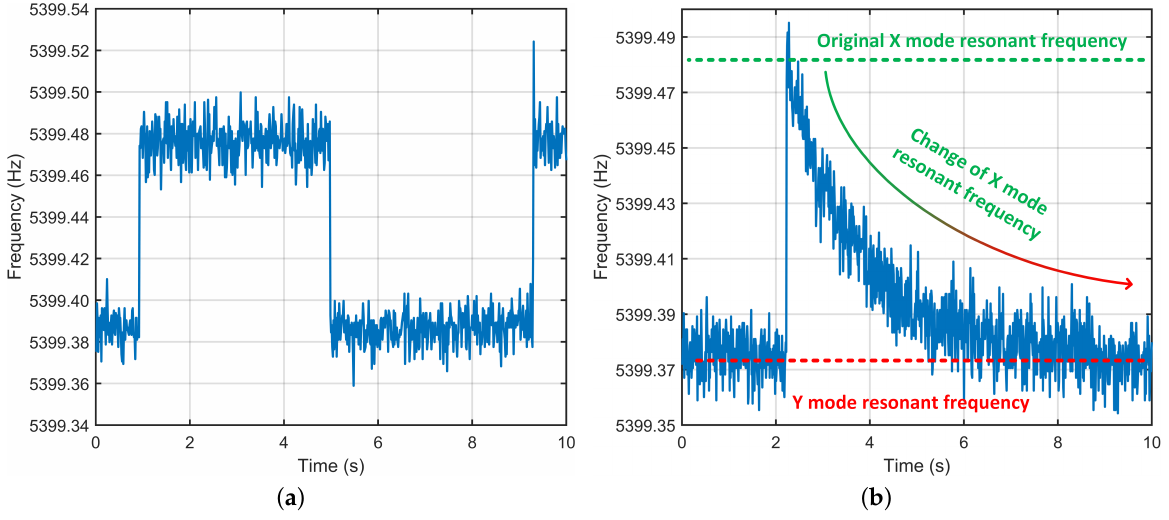
Figure 11. The pre-calibration of frequency split by mode switching. ( a ) The time-division multiplex- ing of PLL. ( b ) The change of resonant frequency during